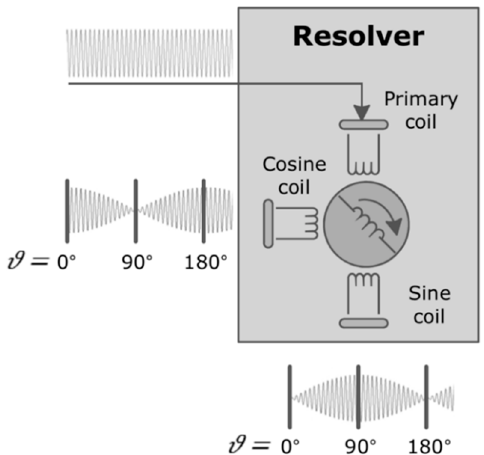
Figure 3. Working principle of a resolver with coil arrangement and amplitude modulated feedback signals [19].